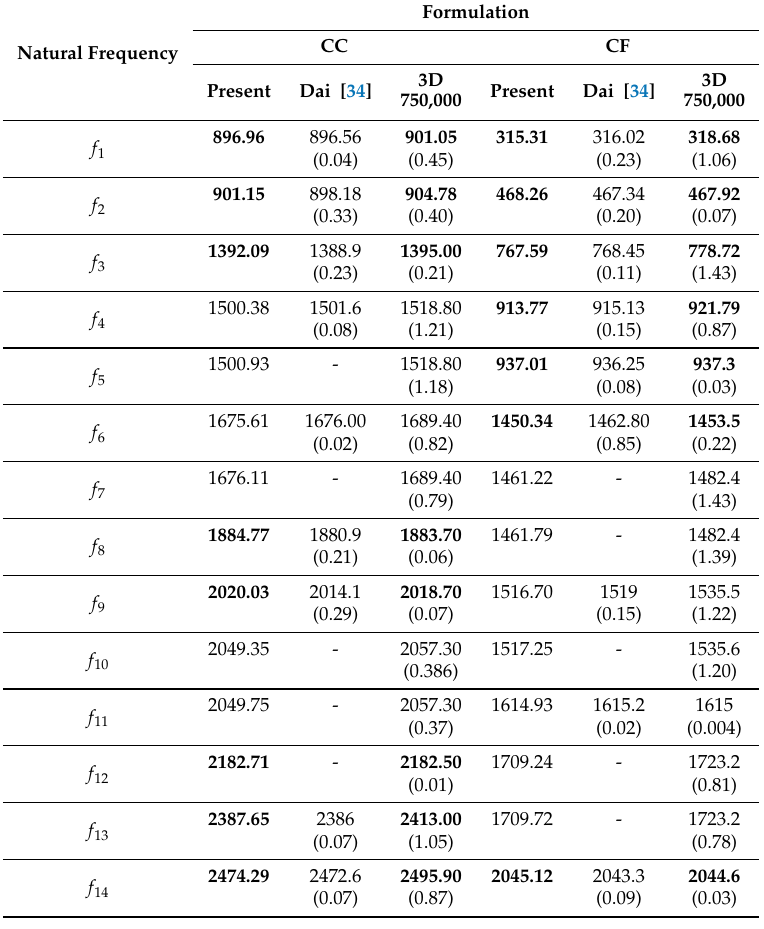
Table 14. Comparison of results for a cylinder with constant thickness.